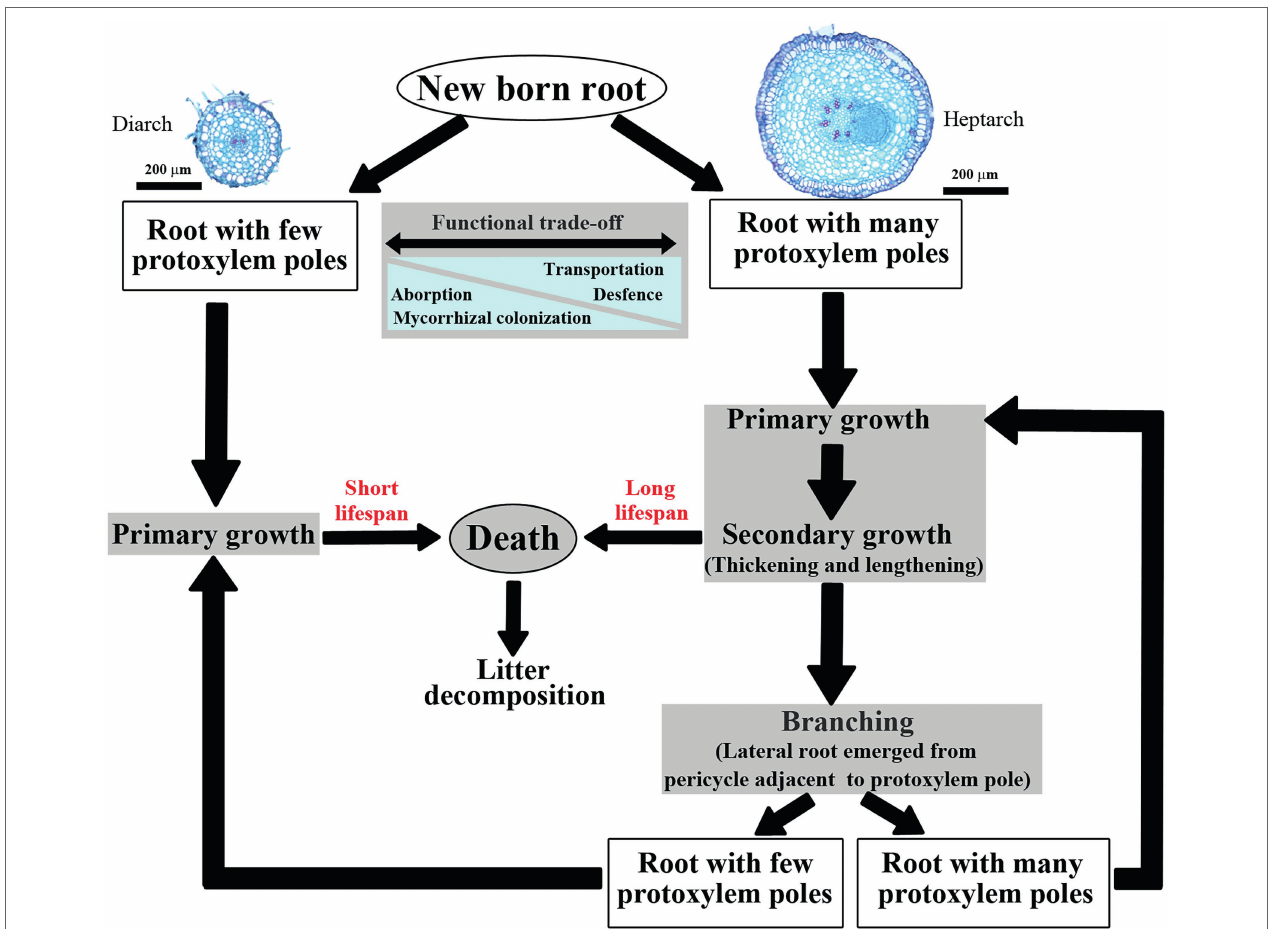
FIGURE 1 | Life cycles of an individual newly formed root. Illustrated two typical roots of Fraxinus mandshurica have two (diarch) and seven (heptarch) protoxylem groups,